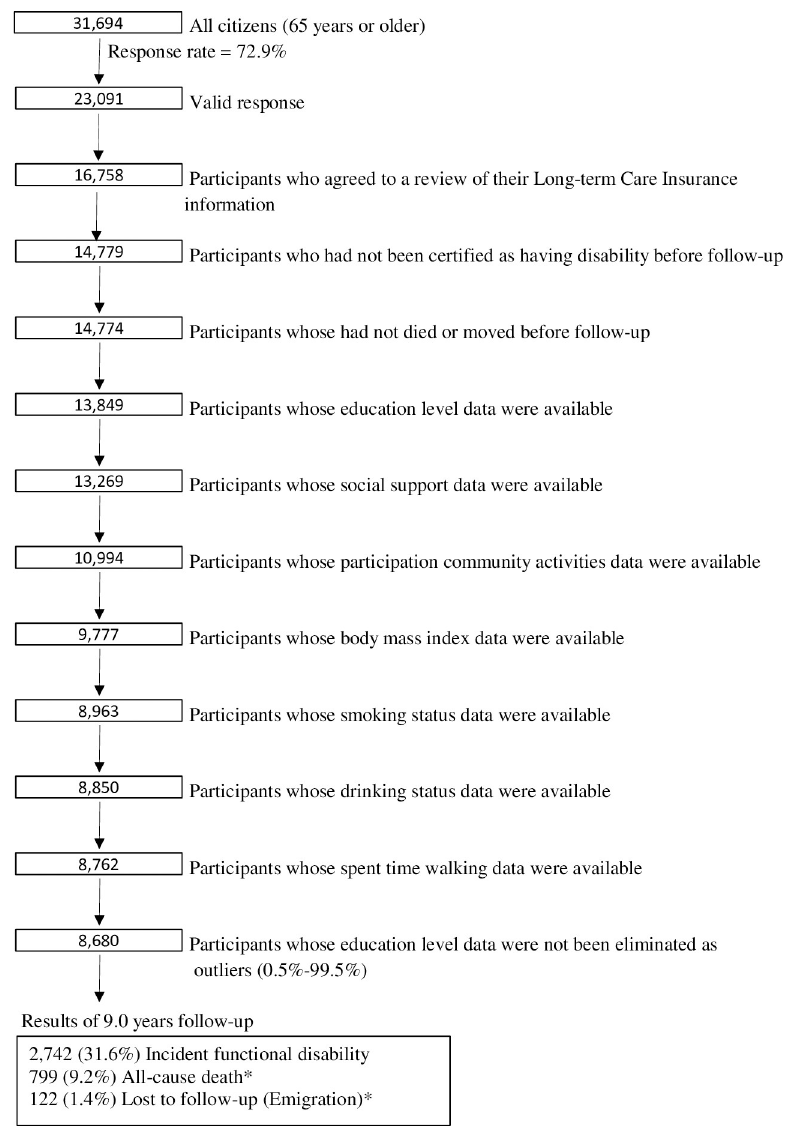
Fig 1. Flow chart of the study participants: The Ohsaki cohort 2006 study, Ohsaki city, Japan, 2006–2015. � without experiencing incident disability.